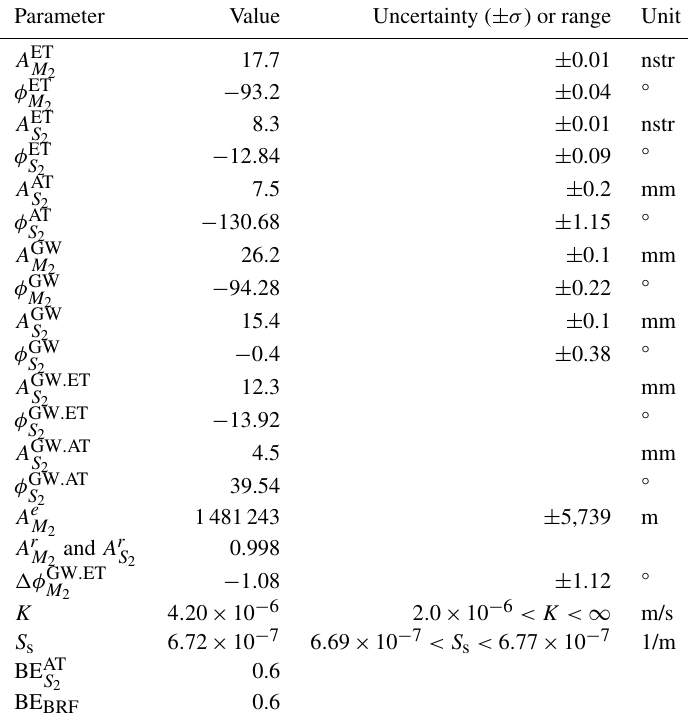
Table 2. Summary of the parameters, values and uncertainties calculated in this work. Parameter Value Uncertainty ( ± σ ) or